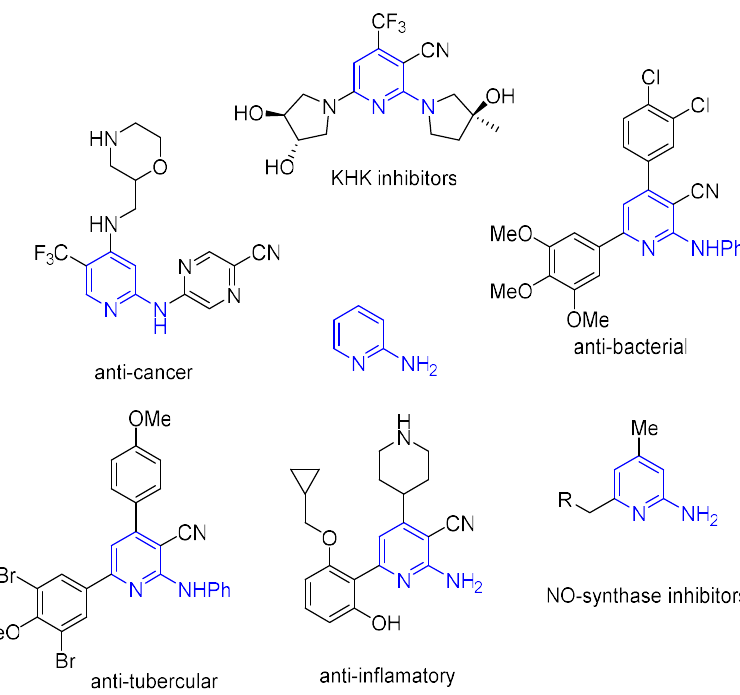
Figure 2. Some bioactive molecules containing the 2-aminopyridine.